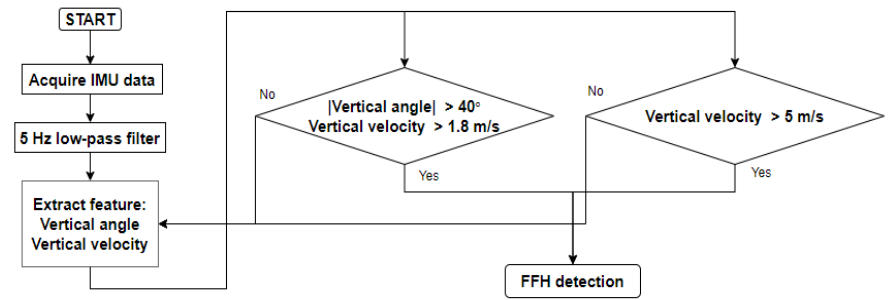
Figure 7. Flowchart of the threshold-based algorithm for detecting FFHs.